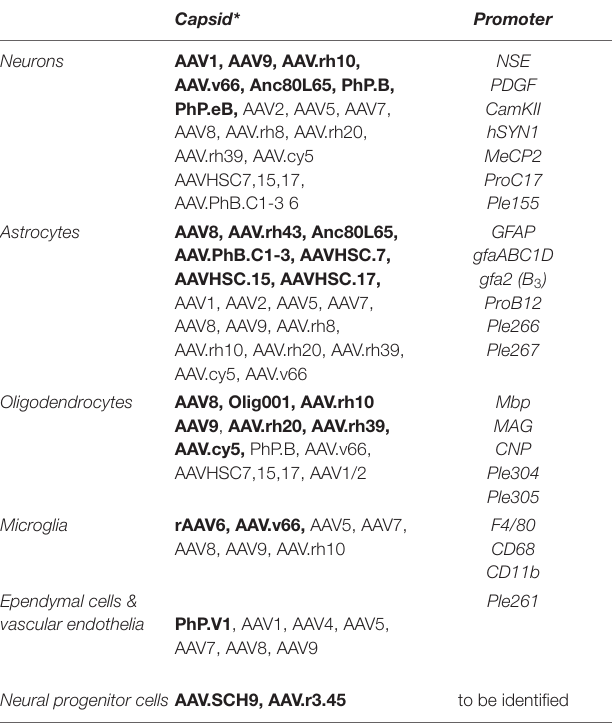
TABLE 1 | Summery of AAV capsids and cell type targeted promoters that achieve AAV mediated transgene expression in neural cells. Capsid*